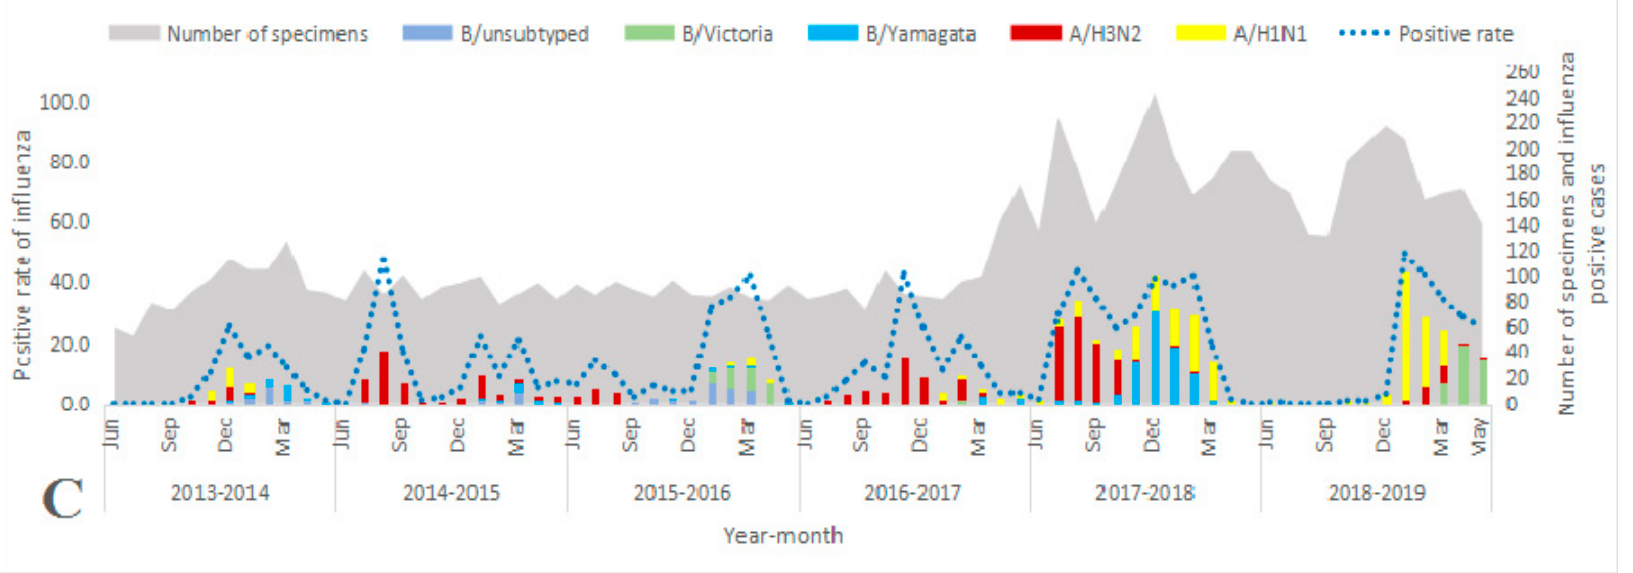
Figure 1. ( a ) Influenza epidemic duration and peak times in Yichang, 2013–2019, using the positive rate as a proxy. The dark blue dot indicates the peak time; ( b ) Distribution of positive rates by subtypes/lineages of influenza viruses A and B in different seasons; ( c ) Temporal trends of influenza virus activity by subtype/lineage. The shaded area represents the total number of specimens tested. The dark blue dotted line indicates the positive rate of influenza.